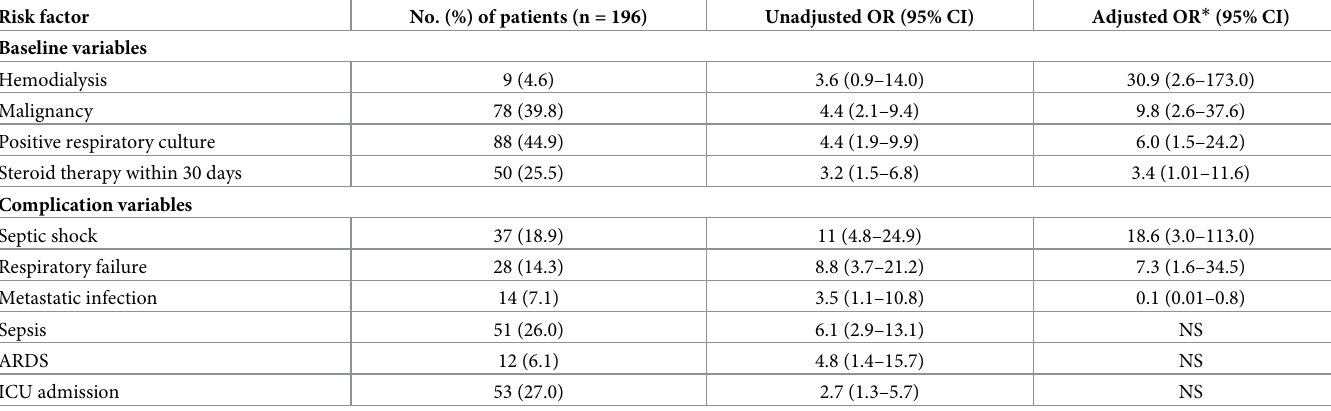
The most common complications encountered were the acquisition of a hospital-acquired infection other than the index infection (28.1%), admission to the intensive care unit (27.0%), sepsis (26.0%), recurrent infection (21.2%), and septic shock (18.9%). In-hospital mortality was 19.4% and mortality was attributed to infection in 26.3% of all patients who died. Mortal- ity was highest when the initial source of infection was pneumonia (30.9%), compared to 15.0% for urinary tract infections, and 6.7% for primary bacteremia. Backward stepwise multi- variable logistic regression was performed to test independent risk factors for mortality (Table 4). On bivariable analysis, sepsis, acute respiratory distress syndrome (ARDS), and ICU admission were associated with a worse outcome. However, this relationship was no longer significant when we adjusted for confounders. A total of 53/196 (27.0%) patients required ICU admission. With a p-value of 0.011, ICU mortality was 17/55 (30.9%) and non-ICU mortality was 21/196 (17.5%). The baseline variable with the strongest independent association with death was hemodialysis (aOR = 30.9; 95% CI 2.6–173.0). This was followed by malignancy